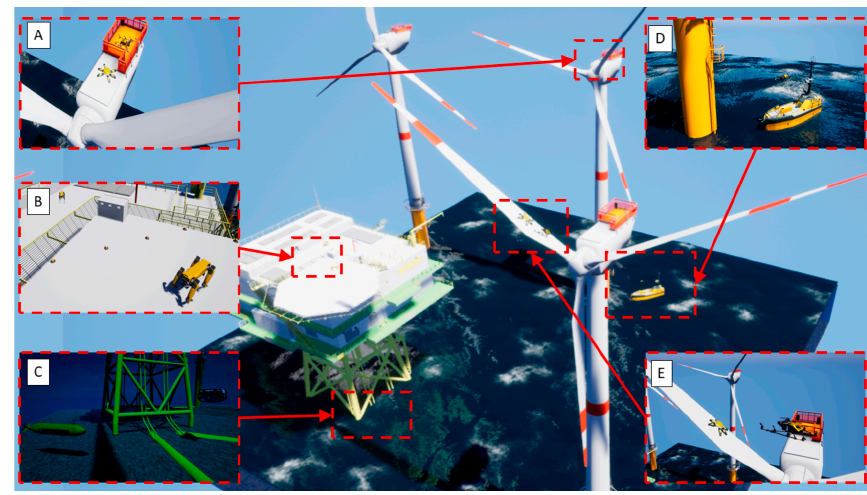
Figure 5. Intelligent operation and maintenance robot [29].